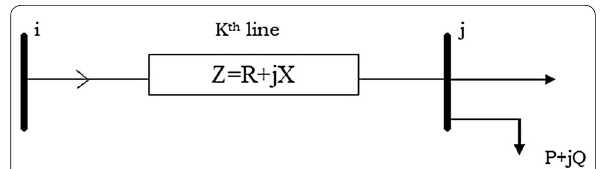
Fig. 1 A distribution line with connected